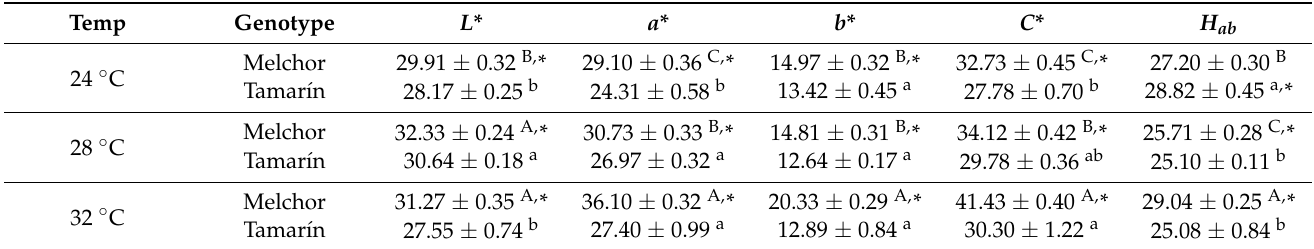
Table 3. Effect of temperature (24 ◦ C, 28 ◦ C, and 32 ◦ C) on color parameters ( L* , a* , b* , C*, and H ab ) of Melchor and Tamar í n fruits.